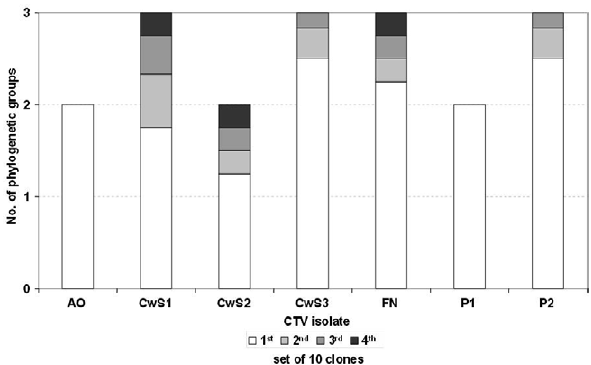
Figure 3. Number of phylogenetic groups detected in a first set of ten clones of seven Citrus tristeza virus isolates, based on the clas- sification proposed by Nolasco et al . (2009), and number of addi- tional variants detected in incremental sets of ten clones, averaged over 24 possible sampling orders of four sets.